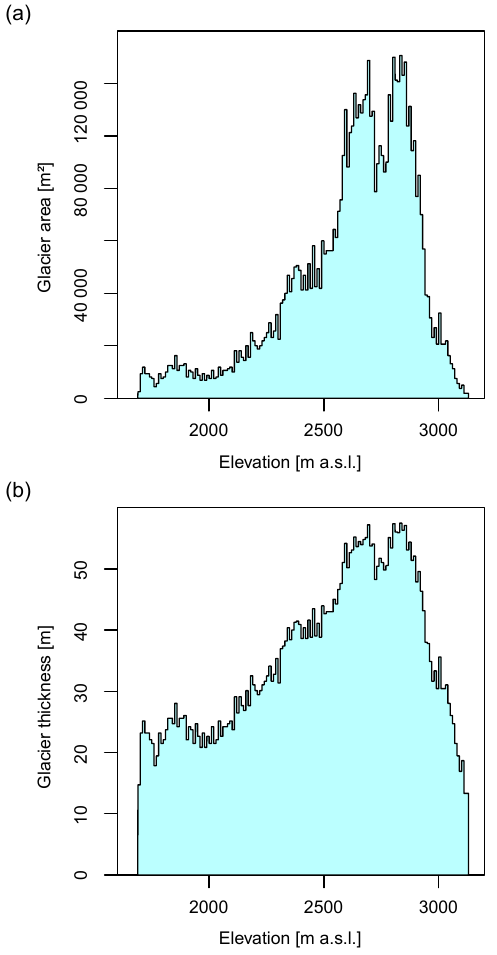
Figure A1. Estimated initial glacier geometry as a function of ele- vation: (a) areal extent and (b) glacier